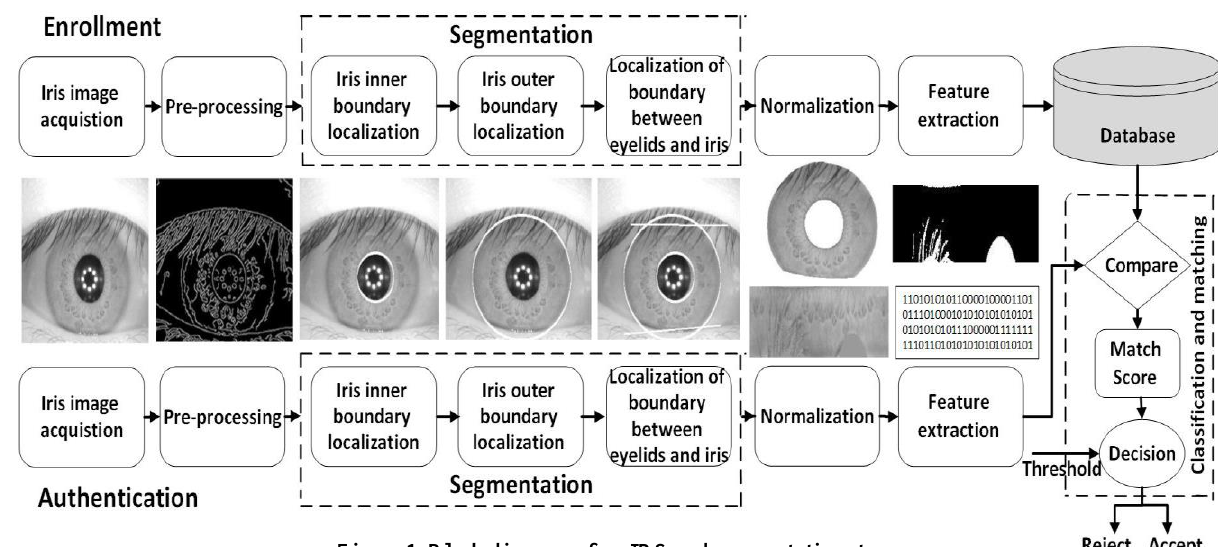
Figure 1. Block diagram of an IRS and segmentation